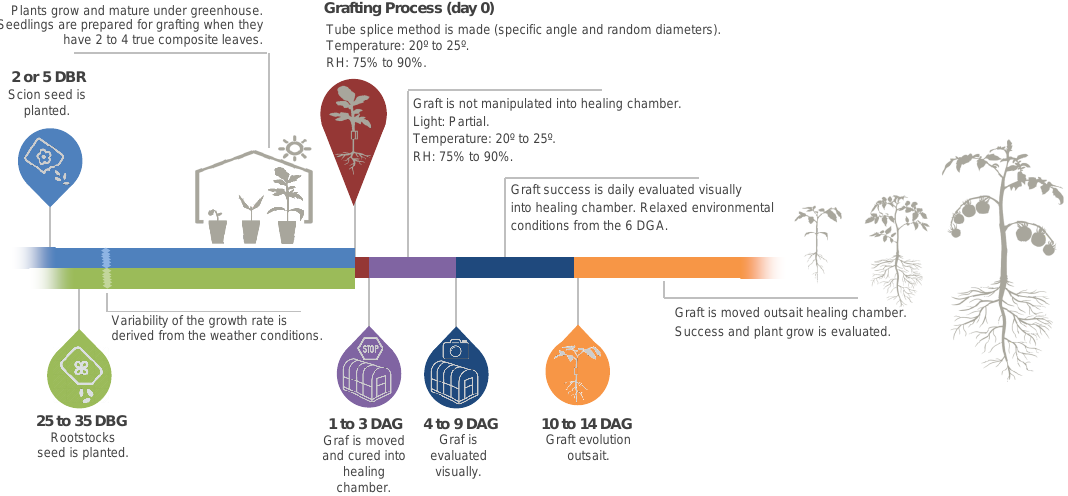
Figure 3. Timeline of the grafting process developed. DBR (days before rootstock has been planted). DBG (days before grafting process). DAG (days after grafting process).